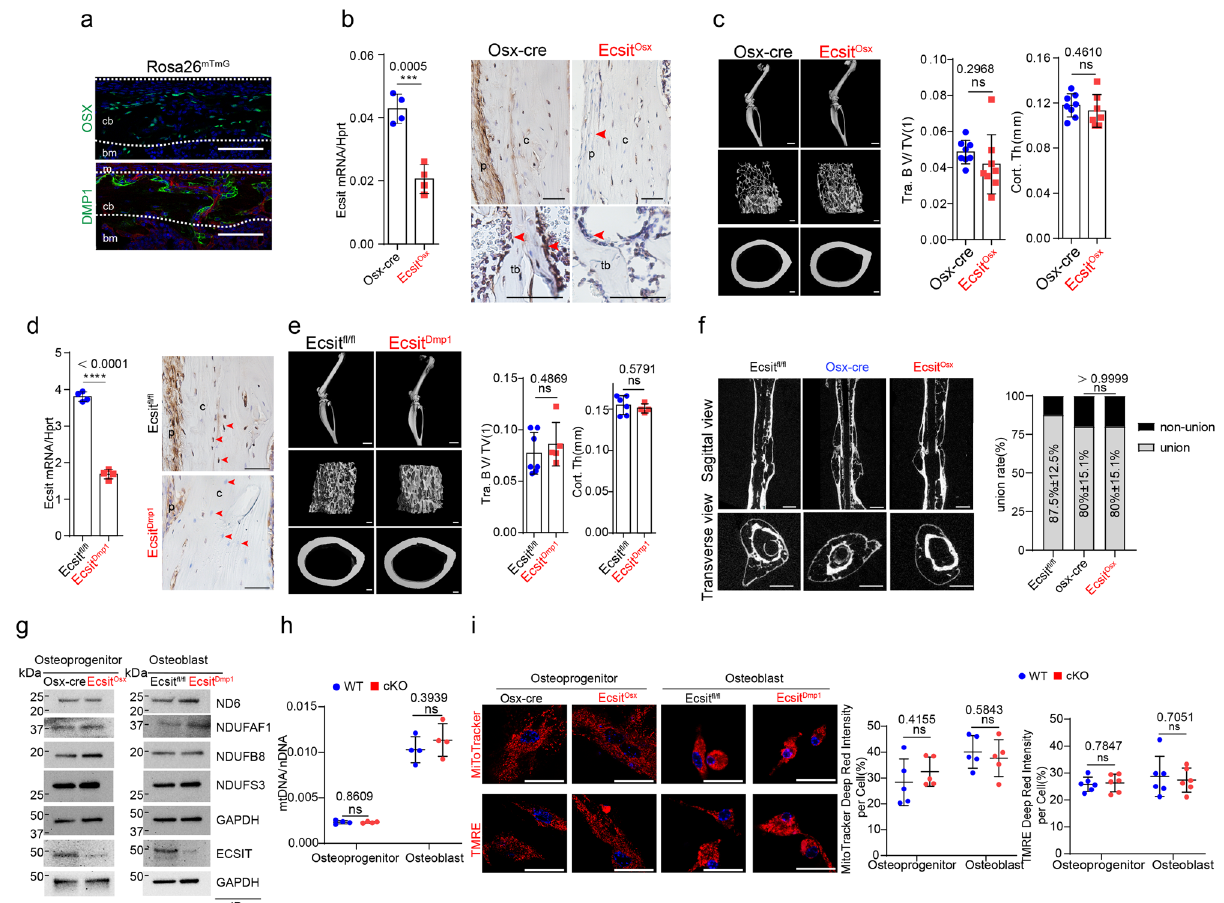
Fig. 4 | Ecsit Osx and Ecsit Dmp1 mice show no skeletal phenotype and intact mito- chondrial function. a GFP-expressing Osterix (OSX)-, DMP1-lineage cells residing in the diaphyseal periosteum of P1 Osx-EGFP and DMP1-cre;Rosa26 mTmG mice, respectively, were monitored by fl uorescence microscopy. m: muscle, bm: bone marrow. b , d mRNA levels of Ecsit in tibia was examined by RT-PCR ( n =4, left ). Immunohistochemistryshowing ECSIT expressionin2-month-old Ecsit Osx , Ecsit Dmp1 , andlittermatecontrolfemurs( right ).p:periosteum,tb:trabecularbone,c:cortical bone. Red arrows indicate Osx + or Dmp1 + lineage osteoblasts or osteoctyes. c , e MicroCT analysis showing 3D-reconstruction images of hindlimbs, femoral trabecular and cortical bones of 2-month-old Ecsit Osx , Ecsit Dmp1 and littermate con- trol mice ( left ), and the relative quanti fi cation of trabecular bone mass (Osx-cre, Ecsit Osx , n =8; Ecsit fl / fl , n =7; Ecsit Dmp1 , n =5) and cortical bone thickness (Osx-cre, n =8; Ecsit Osx , n =7; Ecsit fl / fl , n =6; Ecsit Dmp1 , n =4, right ). Osx-cre limbs were used as controls for Ecsit Osx mice. f MicroCT analysis showing sagittal and transverse views